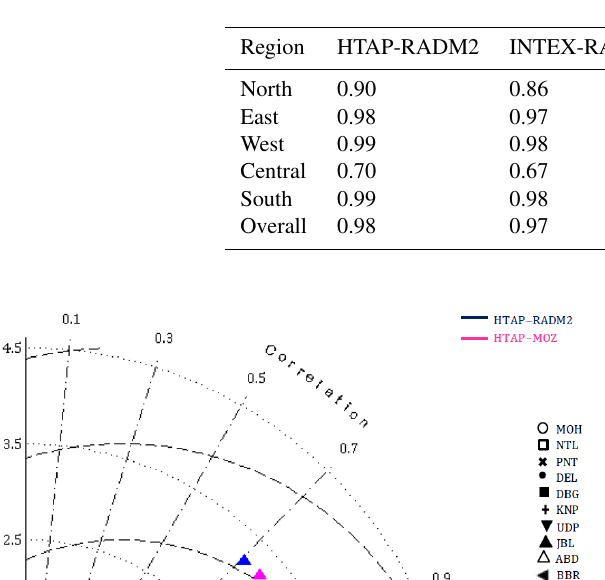
Table 5. A comparison of correlation coefficients ( r ) over different regions for the four simulations.